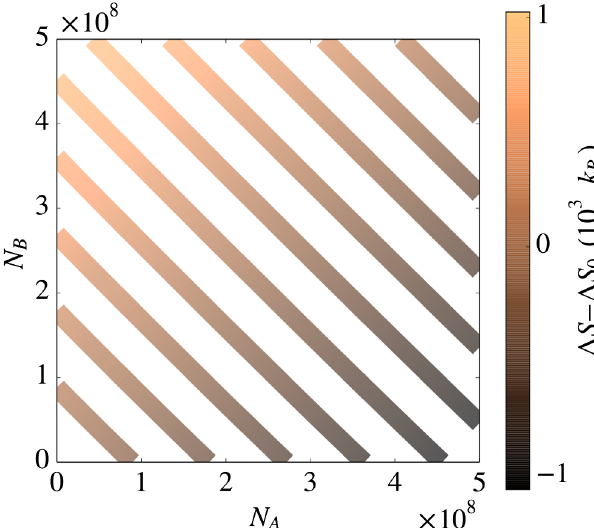
FIG. 5. Lines of fixed reversal probability based on Eq. (18), 1 , g 2 , τ ¼ 10 , and δ ¼ e − 100 . Each line is colored with g A ¼ B ¼ to show the entropy produced while generating each ending state 1 , relative to that of the state on N from the initial state N A ¼ B ¼ N the line where N . On each of these surfaces of fixed B ¼ A reversal probability, the most likely outcome by orders of ≫ N magnitude is one where N B A